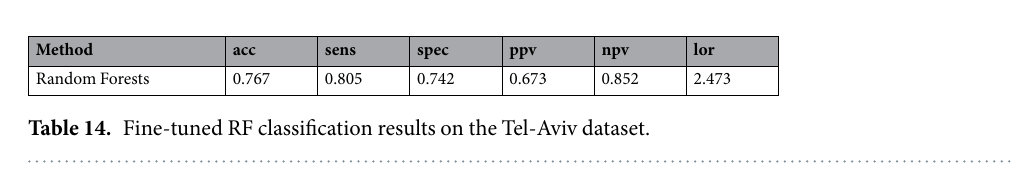
Selected Features